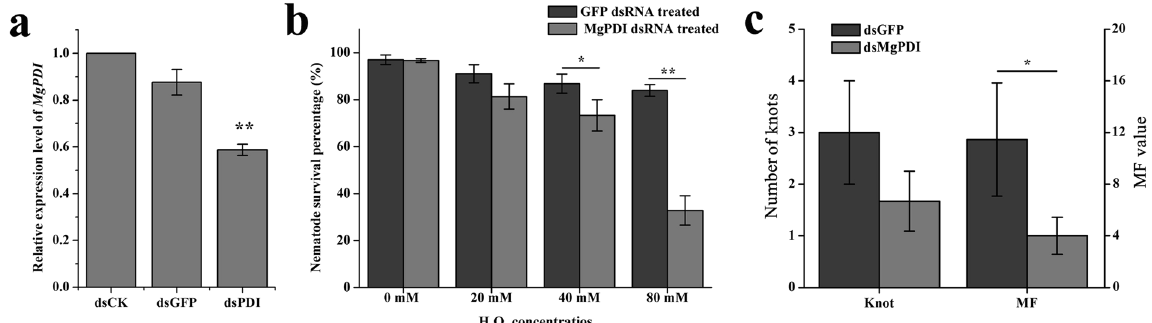
Figure 6. Effect of MgPDI expression on rice susceptibility to M . graminicola infection. ( a ) MgPDI expression in nematode after treatment with dsRNA. Asterisks indicate significant differences based on Tukey’s test ( * P < 0.05; ** P < 0.01). ( b ) Effect of MgPDI silencing on H 2 O 2 stress tolerance. ( c ) Average numbers of knots and the MF values at 15 dpi. Vertical bars represent the means ±